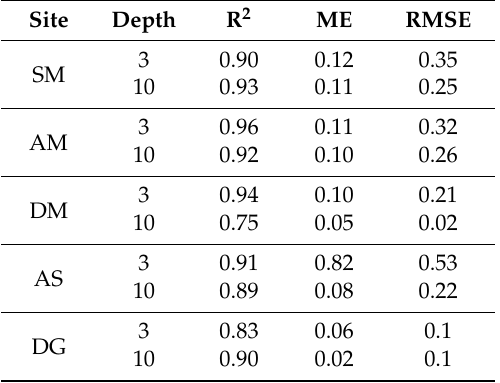
Table 3 . Statistics of the correlation coefficient (R 2 ), mean errors (ME), and root mean square errors (RMSE) between simulated and measured ground temperature at depth of 3.0 m and 10.0 m for five sites.